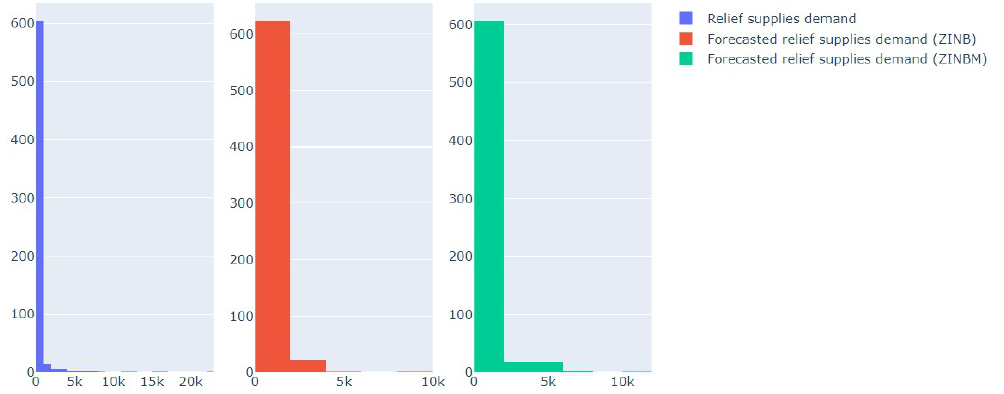
Figure 4. Histogram of actual demand × estimated demand.